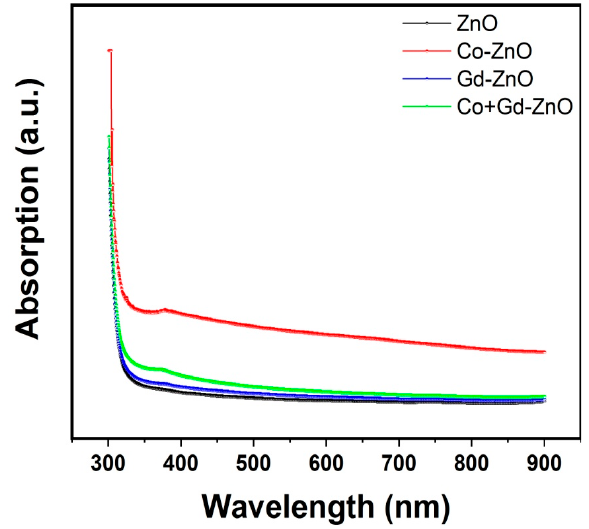
Figure 4. UV-Vis spectrum of pure, Co, Gd, and Co/Gd-added ZnO. In the absorbance spectra, the absorption edge of pure ZnO is found at 356 nm, which resembles the excitation of electrons from the valance to the conduction band. It can be observed that absorption edges shifted towards a wavelength at the higher end (known as redshift) for added samples. The redshift in the absorption edge is ascribed to an expansion of the surface area, oxygen vacancies, and the replacement of Zn ions in the ZnO lattice by Co and Gd